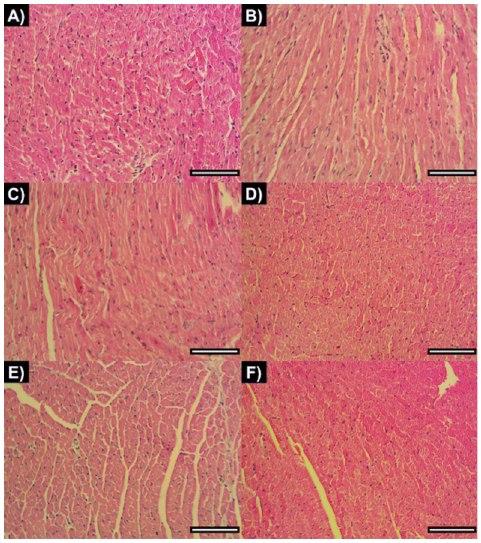
Fig 3. Representative images of H&E stained-cardiac tissue from ( A ) non-infected, ( B ) infected untreated, ( C ) E6020-SE, ( D ) low BNZ, ( E ) vaccine and ( F ) low BNZ plus vaccine experimental groups. Five-nine representative photographs were taken from the myocardial region and were acquired at 20X magnification using a microscope adapted with a digital camera. Cell cytoplasm appears in pink and the nuclei of infiltrating inflammatory cells appear in purple. Scale bar corresponds to 10 μ